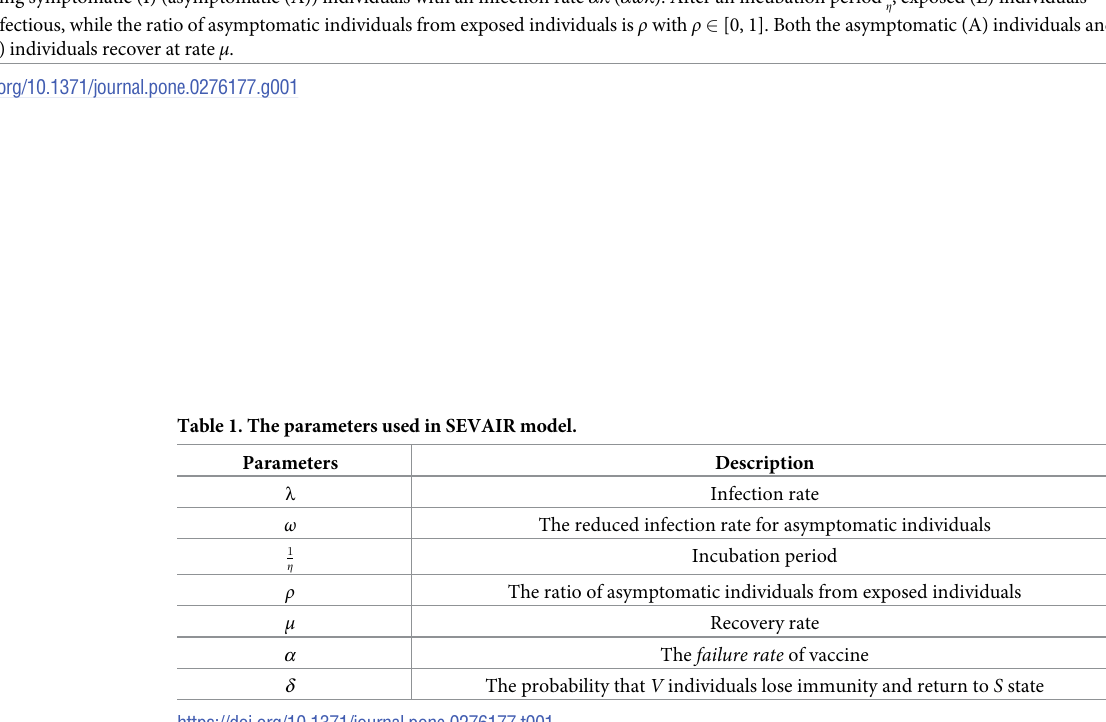
, exposed (E) individuals Z